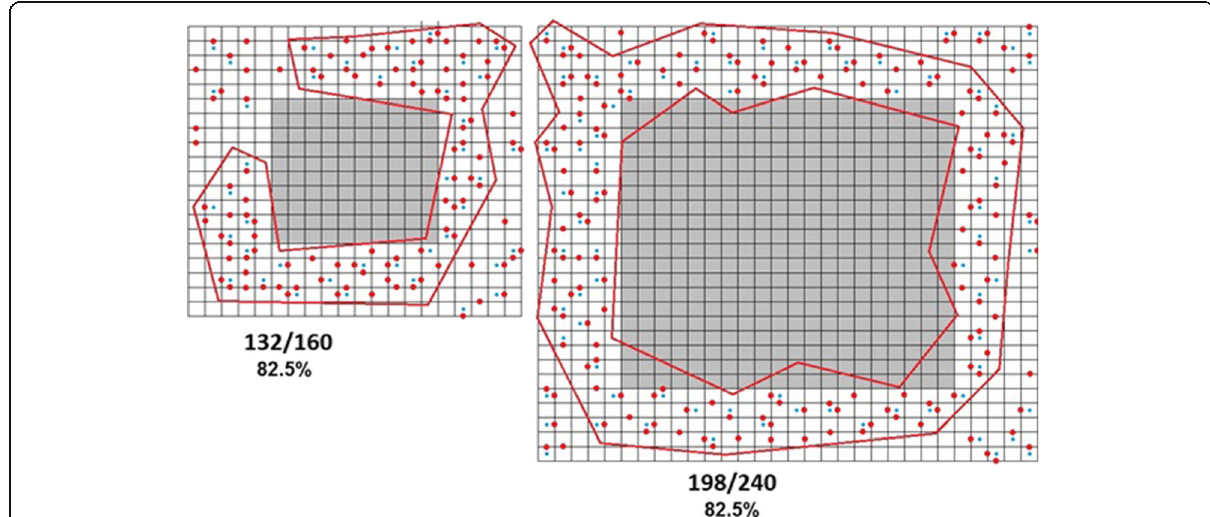
Fig. 8 Infinite cluster formation in the particles of different size. The percolation threshold is 82.5%, defined as the percentage ratio of defects in the cluster is not dependent on particle size, as